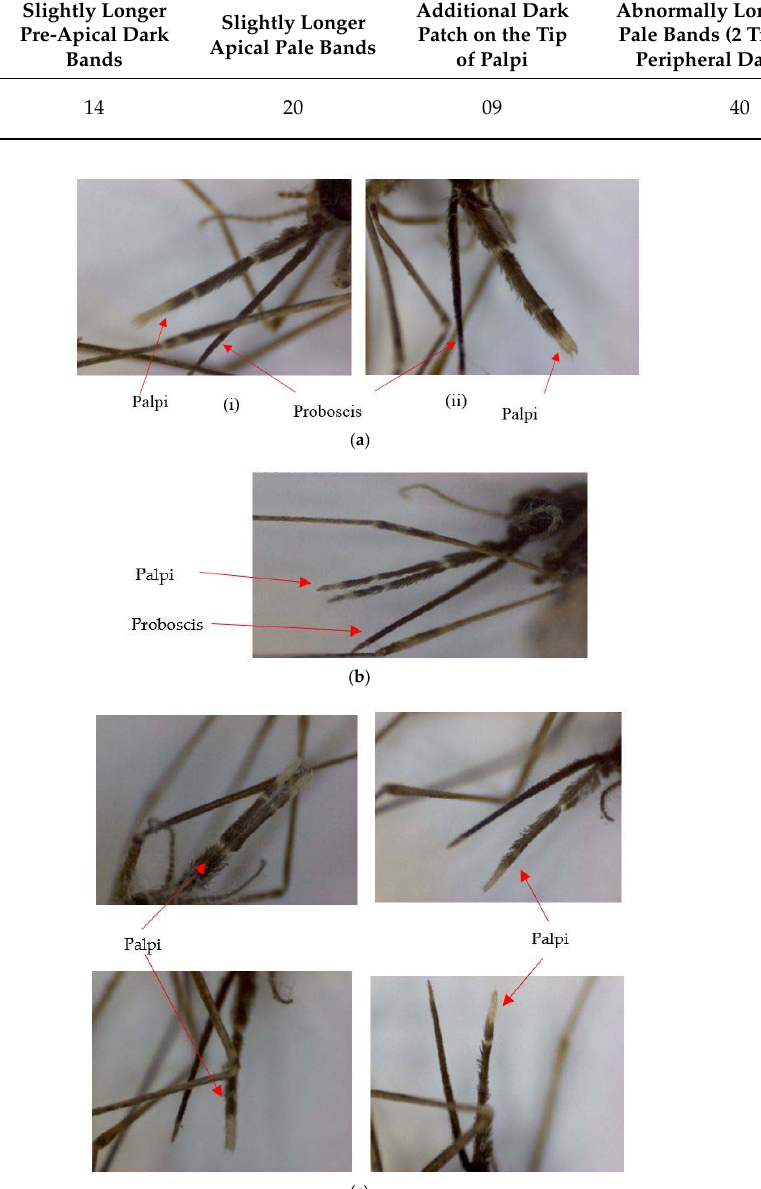
Figure 3. ( a ) Mosquitoes of the same isofemale progeny having (i) slightly longer preapical dark bands and (ii) slightly longer apical pale bands (×200×2); ( b ) palpi with an additional dark patch present at the tips (×200×2); ( c ) palpi with abnormally longer apical pale bands (×200×2). Table 4. Percentages of deviations from existing morphological discrimination characteristics (Suguna et al.